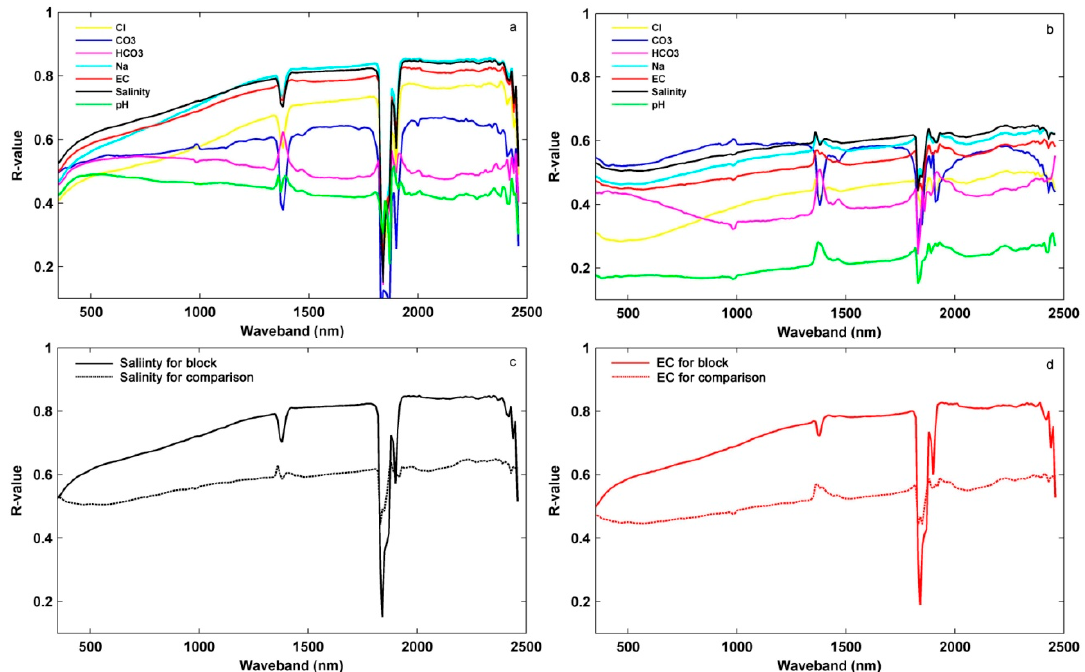
Figure 6. Correlograms between reflectance and main soil properties of soil samples. ( a ) Block soil samples, ( b ) comparison soil samples, ( c ) correlogram for salinity of the block and comparison soil samples, ( d ) correlogram for EC of the block and comparison soil samples.